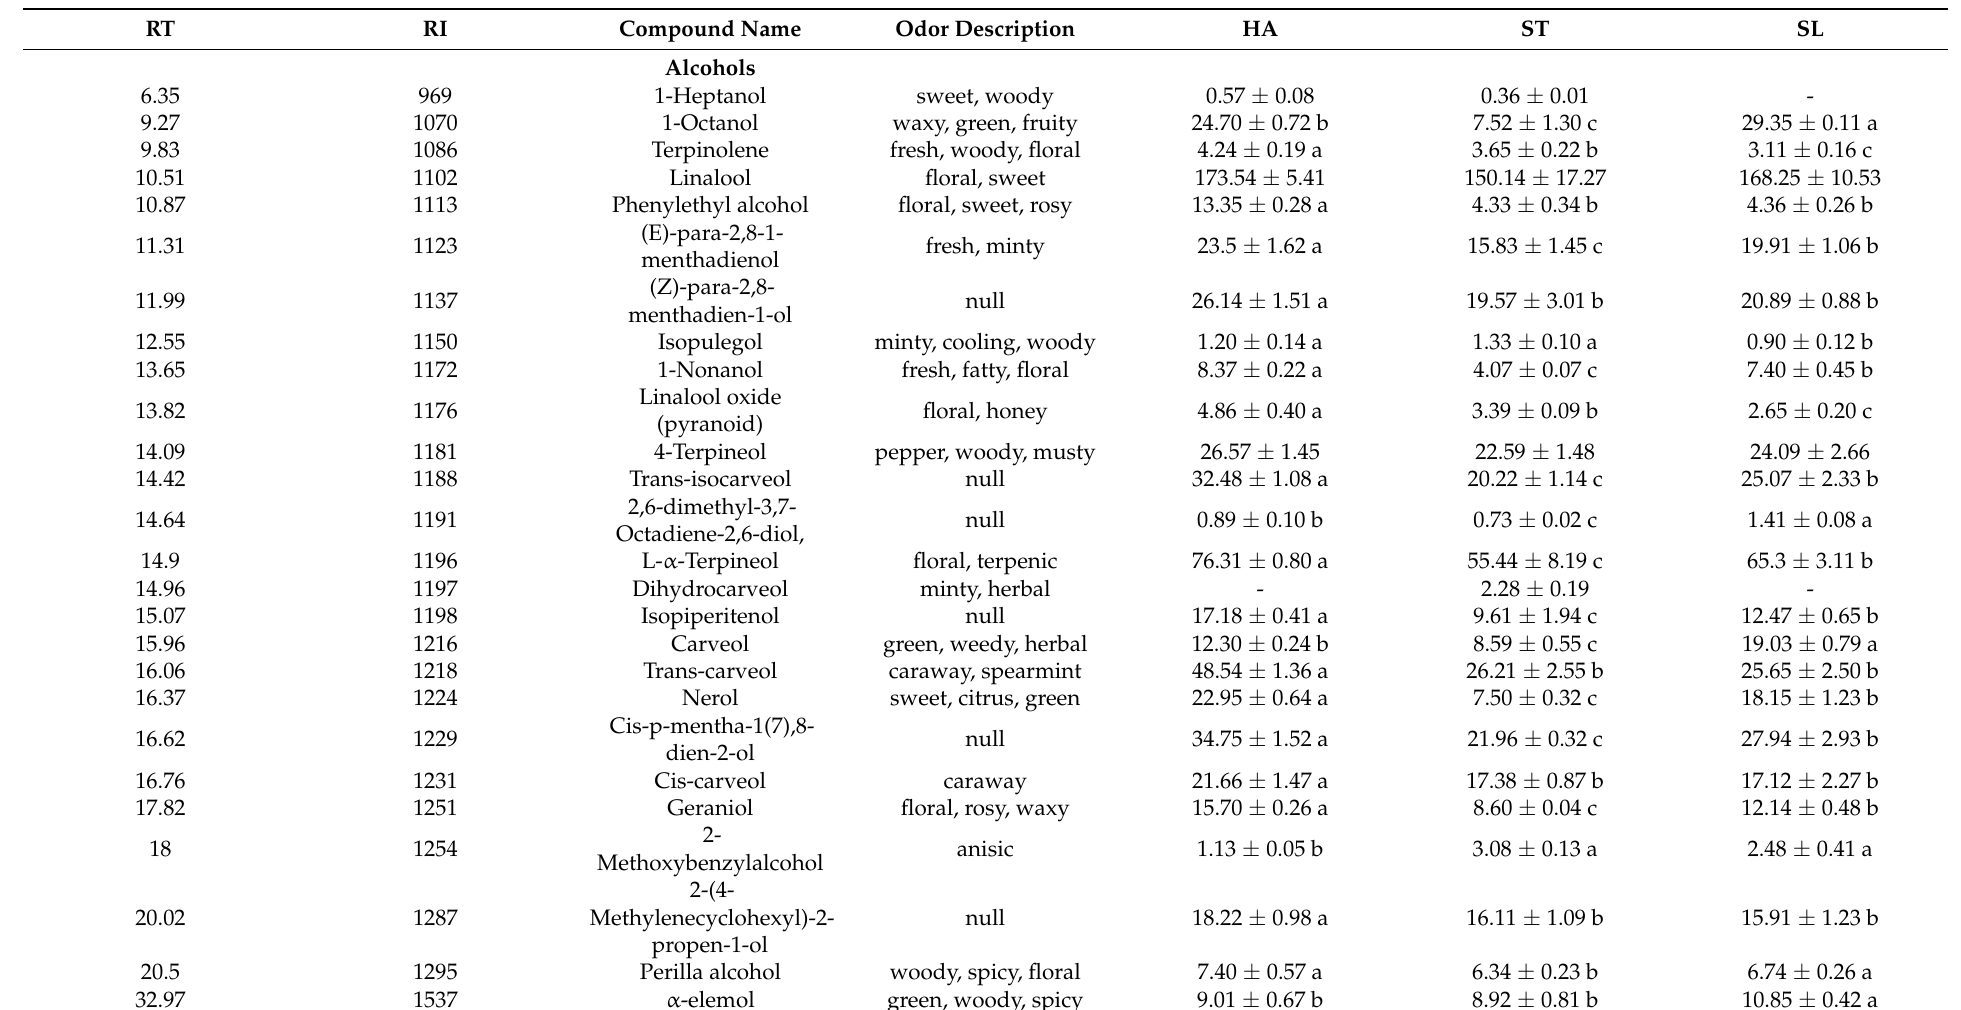
Table 2. Analysis of volatile components in orange dark tea with different fixing methods ( µ